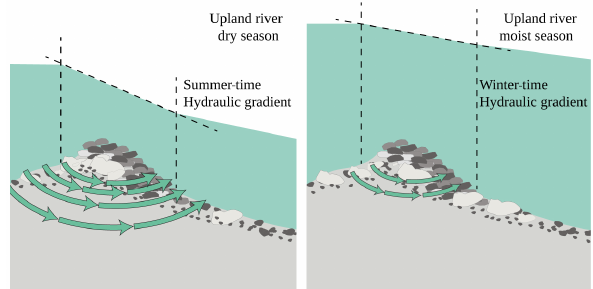
Figure 4. Conceptual representation of seasonal variation of hy- draulic gradient with water stages in an upland environment. Devel- opment of hyporheic exchange in a riffle considering extension and contraction of hyporheic sediment.